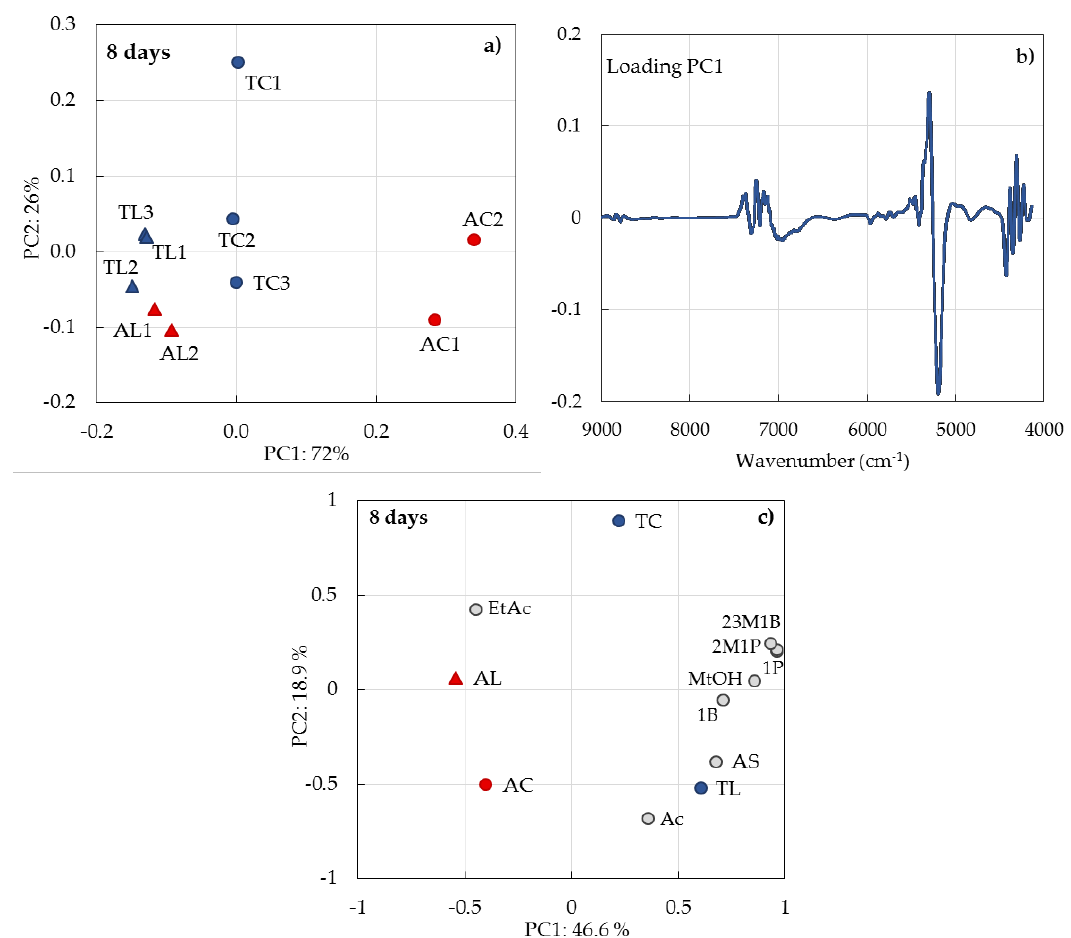
Figure 3. Principal component analysis of wine spirit aged by the traditional and alternative technologies with chestnut and oak wood for 8 days for: ( a ) scores of near-infrared spectroscopy (NIR) spectral information; ( b ) loadings of NIR spectral information; ( c ) standardised scores and loadings of analytical parameters measured. TC—aged in 250 L chestnut new barrels; TL—aged in 250 L oak new barrels; AC—aged in 1000 L stainless steel tanks with chestnut wood staves and micro-oxygenation; AL—aged in 1000 L stainless steel tanks with oak wood staves and micro-oxygenation. AS—alcohol strength (%); MtOH—methanol (g/mL); Ac—acetaldehyde (mg/mL); EtAc—ethyl acetate (mg /